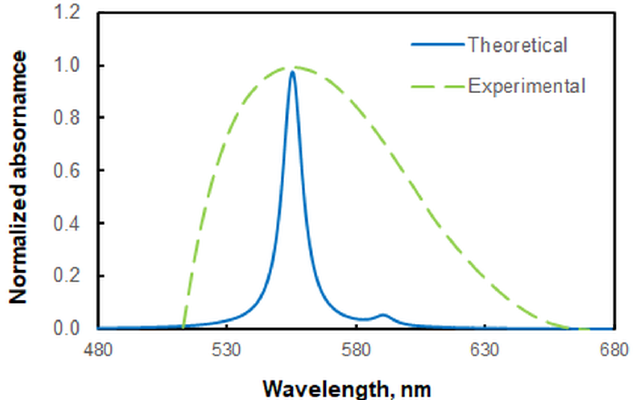
Figure 7. B3LYP-optimized ground-state equilibrium geometries of the cation ( a ) and anion ( b ). Visualization using the Chemcraft graphical program (https://chemcraftprog.com (accessed on 1 February 2023)).